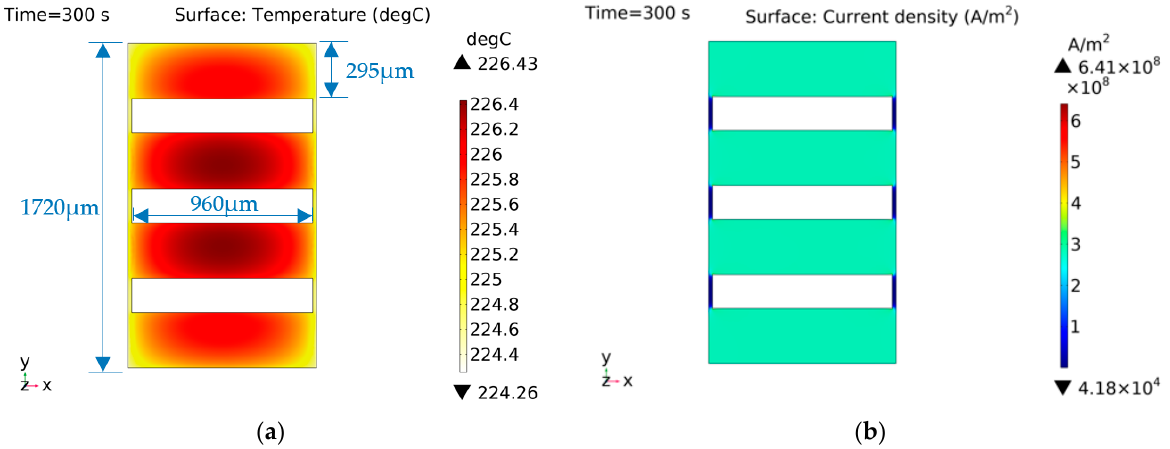
Figure 16. Characteristic distribution of shape B with a constant current (1 A) excitation. ( a ) Tem- perature distribution; ( b ) current density distribution.